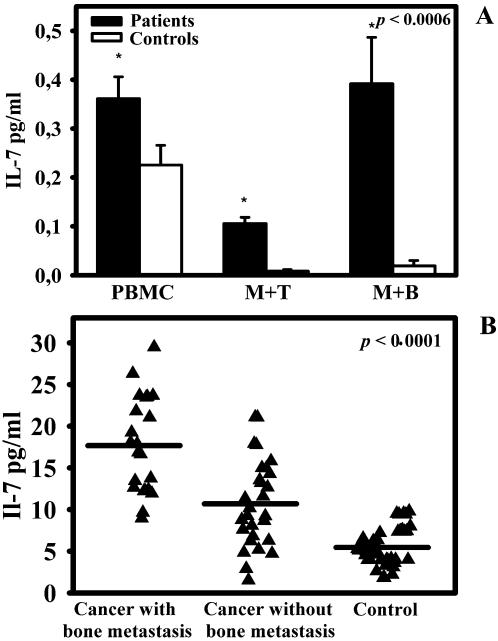
IL-7 levels in cell culture medium and serum.IL-7 levels in cancer patients with/without bone metastases and in healthy controls were analysed by ELISA. At day 5, supernatants of patients' PBMC cultures and monocyte plus T and B cell co-colture had IL-7 levels higher than healthy controls (A). Bone metastatic patients had significantly higher serum levels of IL-7 compared to patients without bone metastasis and healthy controls (B). Samples were assayed in duplicate and data were expressed as mean values.